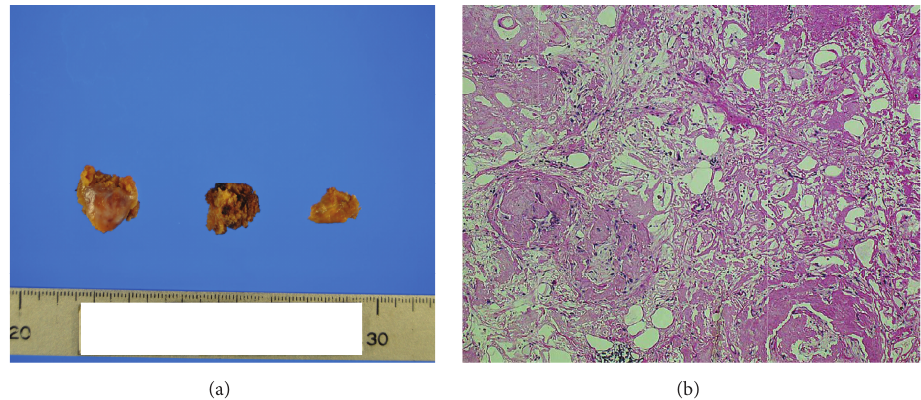
Figure 2: Biopsy of the mesenteric lesion showing poor cellular components and hyalinized, degenerated tissue with a small amount of fat. No evidence of the infiltration of inflammatory cells and tumor cells ((a) macrograph, (b) hematoxylin and eosin stain: objective lens, × 20).